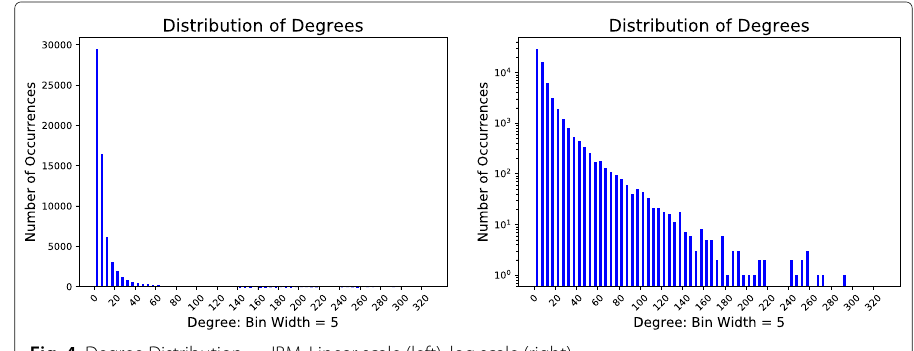
Fig. 4 Degree Distribution — IBM. Linear scale (left), log scale